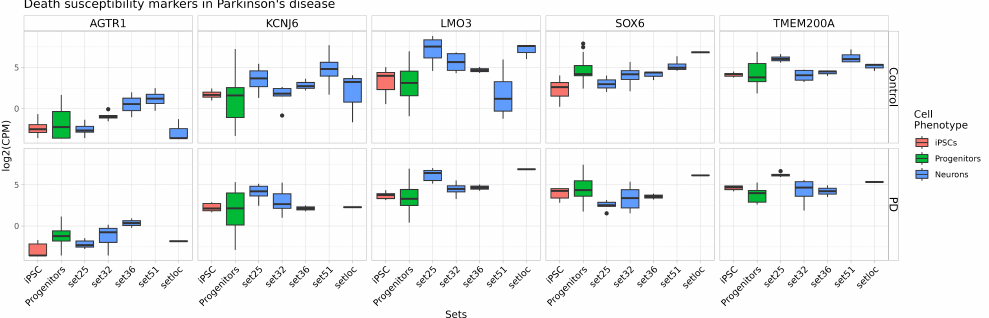
Figure 10. Expression levels of markers of vulnerable DAn subtype and resistant DAn subtype in comparison between